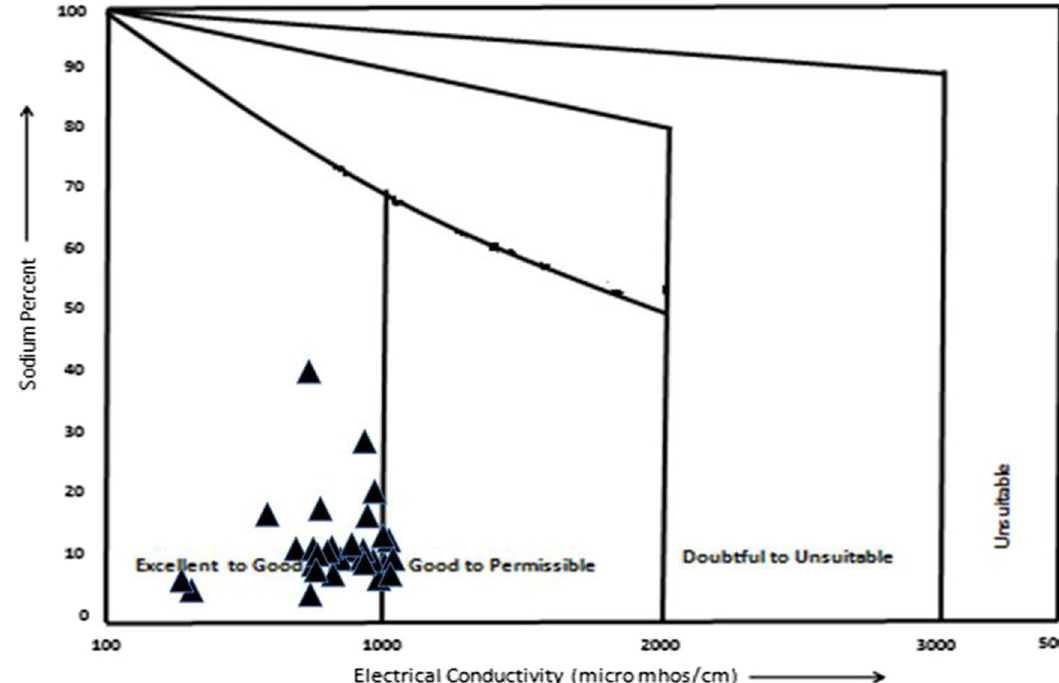
Fig. 37 Wilcox diagram